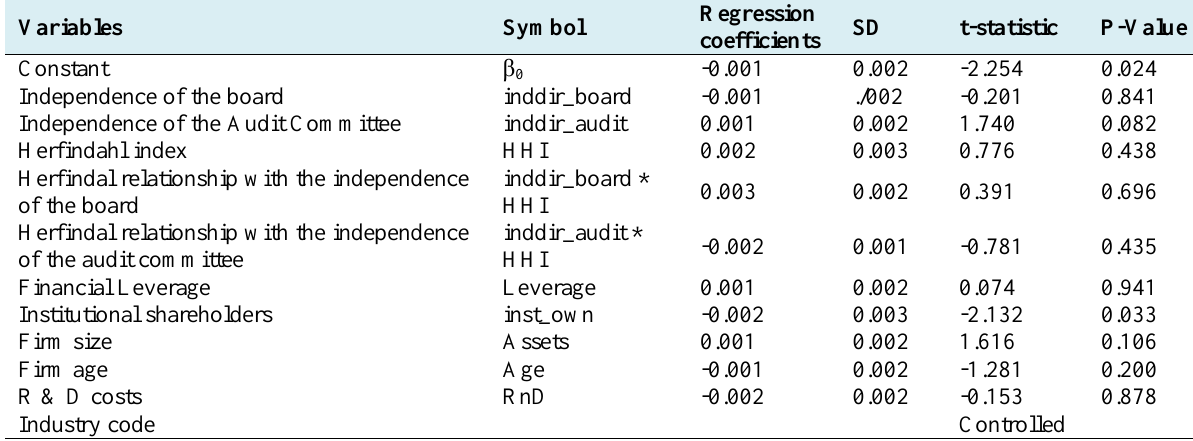
Table 6 . Results of model fitting related to the second criterion of opinion shopping (a simultaneous increase